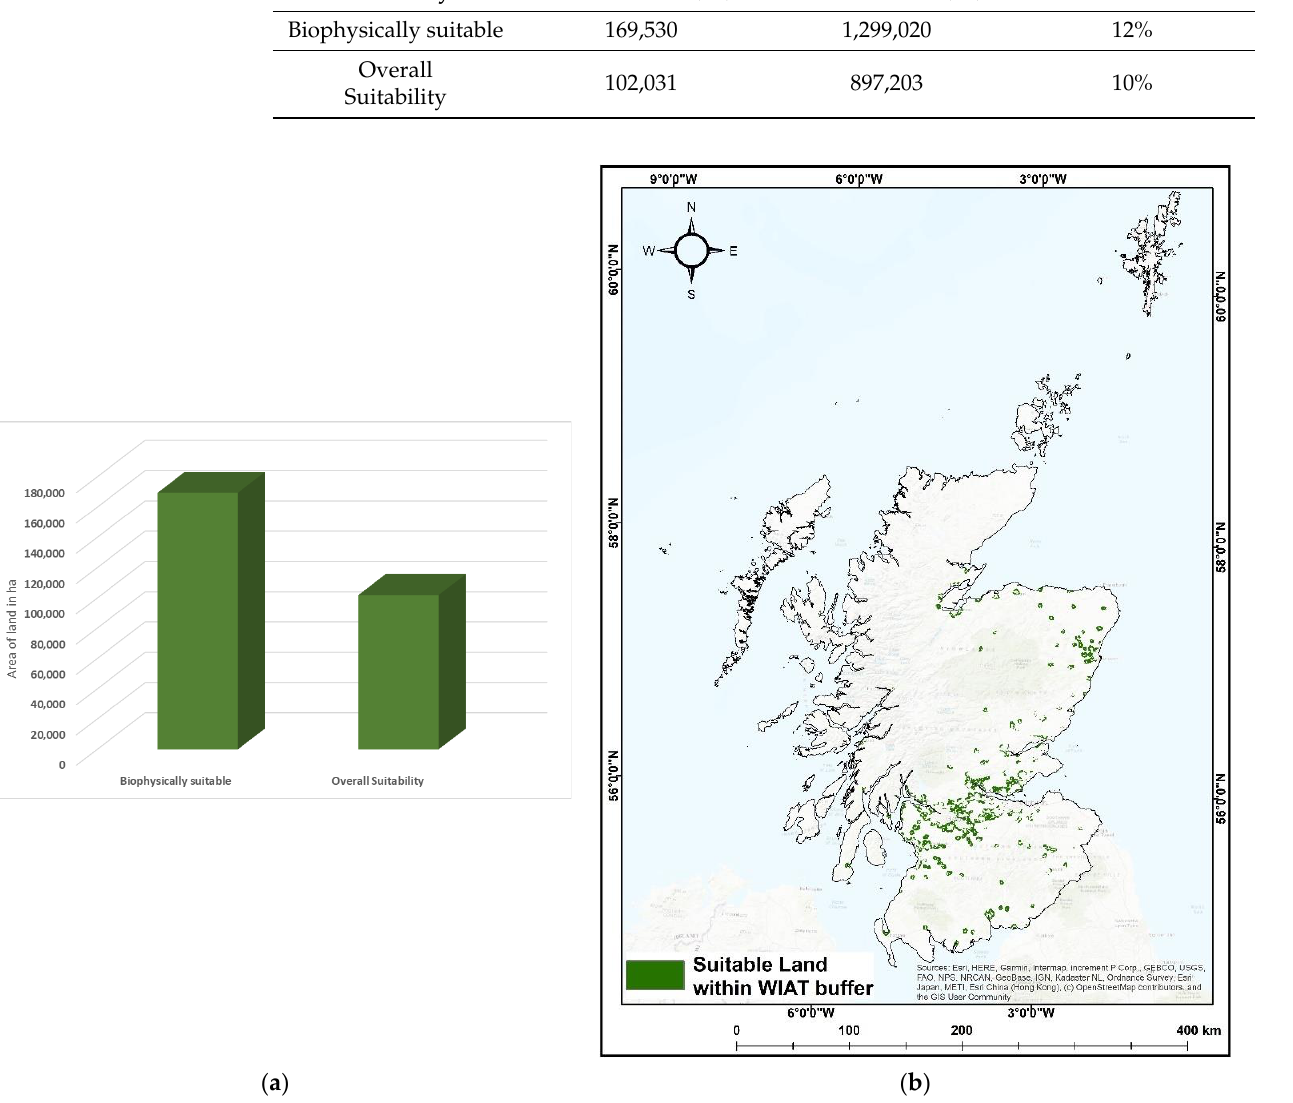
Figure 8. ( a ) Area of land that is biophysically and overall suitable and within WIAT 1 km buffer. ( b ) Locations in Scotland that are suitable for Sitka spruce based on biophysical and policy constraints and within WIAT 1 km buffer.